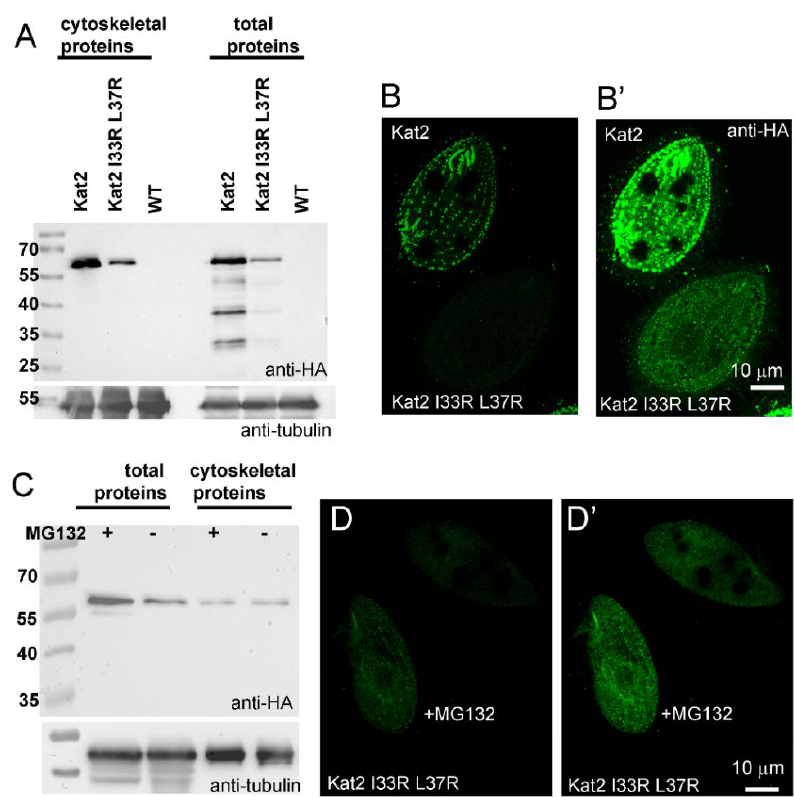
Figure 5. LisH domain plays a role in protein stabilization. ( A ) A Western blot comparative analysis of the levels of Kat2-HA and Kat2-HA I33R L37R in the cytoskeletal and total extracts of cells overexpressing one of these proteins. Corresponding fractions isolated from the wild-type cells (WT) were included as a control of the anti-HA antibody specificity. Tubulin (recognized by the 12G10 monoclonal antibody) was used as a loading control. ( B , B’ ) Confocal images of the mixed cells overexpressing either Kat2-HA or Kat2-HA I33R L37R. Before fixation, cells expressing Kat2-HA were cultured for 10 min in SPP medium supplemented with an India ink and thus have dark food vacuoles. Note the lower signal of the mutated Kat2-HA I33R L37R protein compared to Kat2-HA (cell with dark vacuoles). ( B , B’ ) show the same cells, but on ( B’ ) cells, were overexposed to enhance the signal of Kat2-HA I33R L37R. ( C ) A Western blot analysis of the level of Kat2-HA I33R L37R in total and cytoskeletal extracts of cells overexpressing this protein and treated with MG132 (+), a 26S proteasome inhibitor, or with 0.4% DMSO (−). Tubulin was used as a loading control. Note that MG132 treatment increases the total amount of Kat2-HA I33R L37R, but does not visibly affect the amount of Kat2-HA I33R L37R in the cytoskeletal fraction. ( D , D’ ) Immunofluorescence confocal images of cells overexpressing Kat2-HA I33R L37R for 6 h and treated with MG132 (+MG132) or with 0.4% DMSO (control, labeled with an India ink before fixation and thus having dark food vacuoles). Cells were mixed on the cover slip and fixed. ( D , D’ ) show the same cells, but on ( D’ ) cells, were overexposed to enhance the signal of Kat2-HA I33R L37R. Note an increased level of the Kat2-HA I33R L37R in MG132-treated cells. Bar = 10 μm.